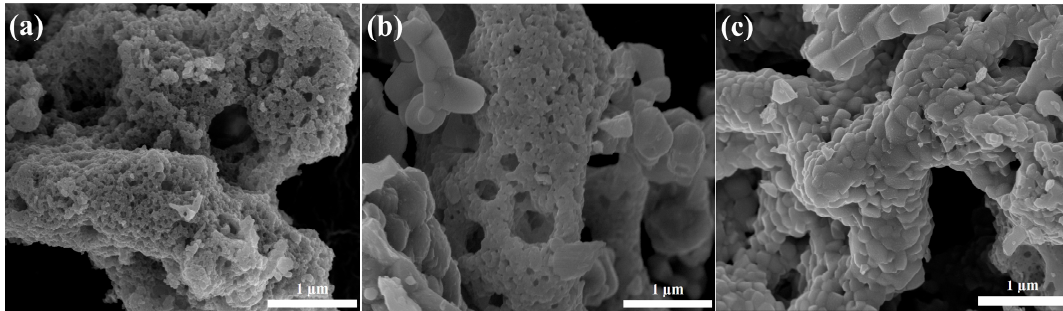
Figure 1. SEM images for Co- and Mn-based materials with ( a ) Co 1.2; ( b ) Co 2.4; and ( c ) Co 2.7.